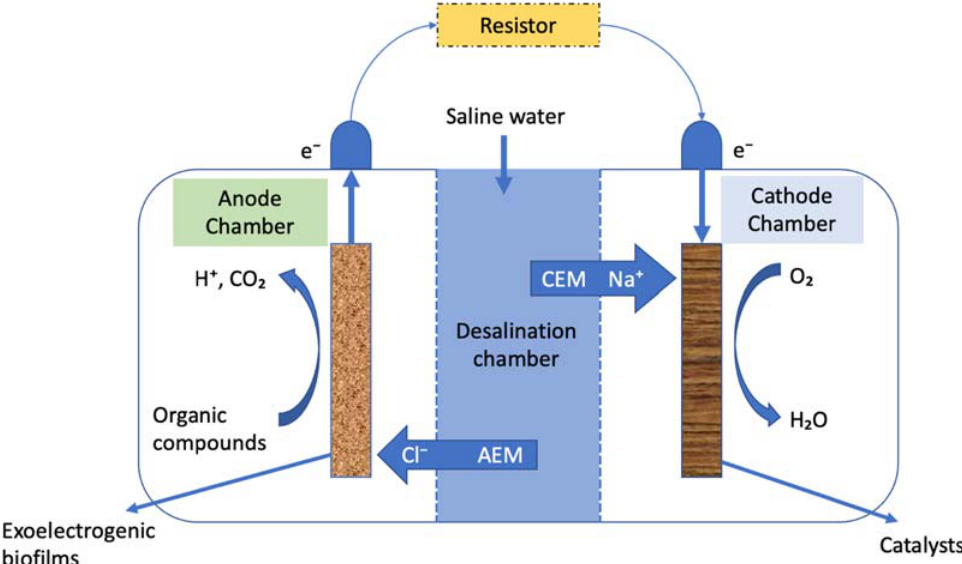
Figure 2: Schematic of an MDC [ 51 ]